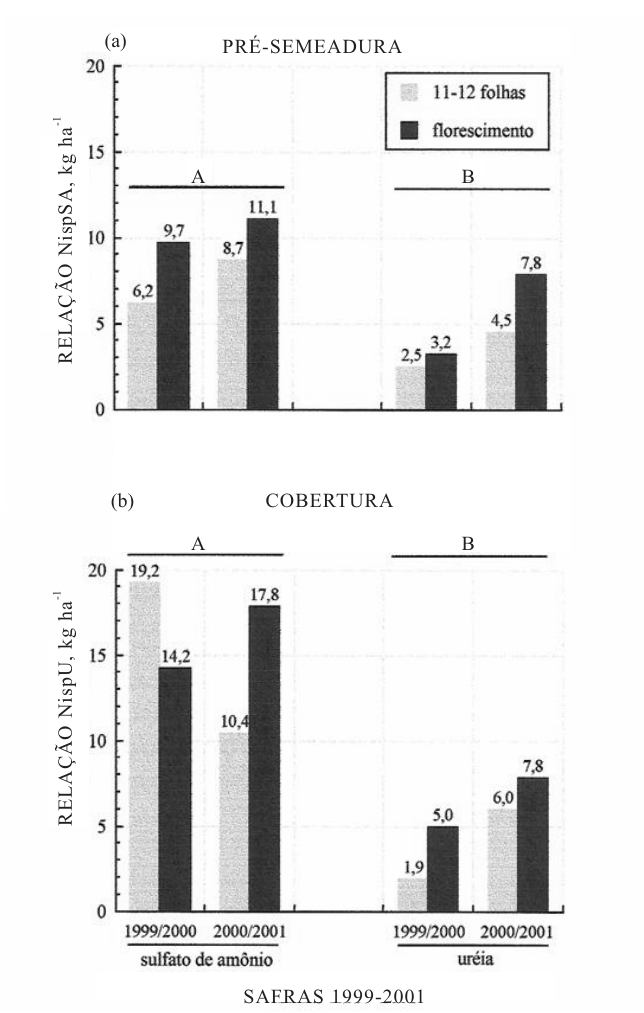
Figura 6. Razão de Nppf/Nispf após a aplicação de sulfato de amônio e uréia em pré-semeadura (a) e em cobertura (b) nos estádios de 11–12 folhas e florescimento, em duas safras consecutivas plantio direto. Médias seguidas de letras maiúsculas desiguais, entre fontes para cada época, diferem significativamente pelo teste de Mann-Whitney (P =